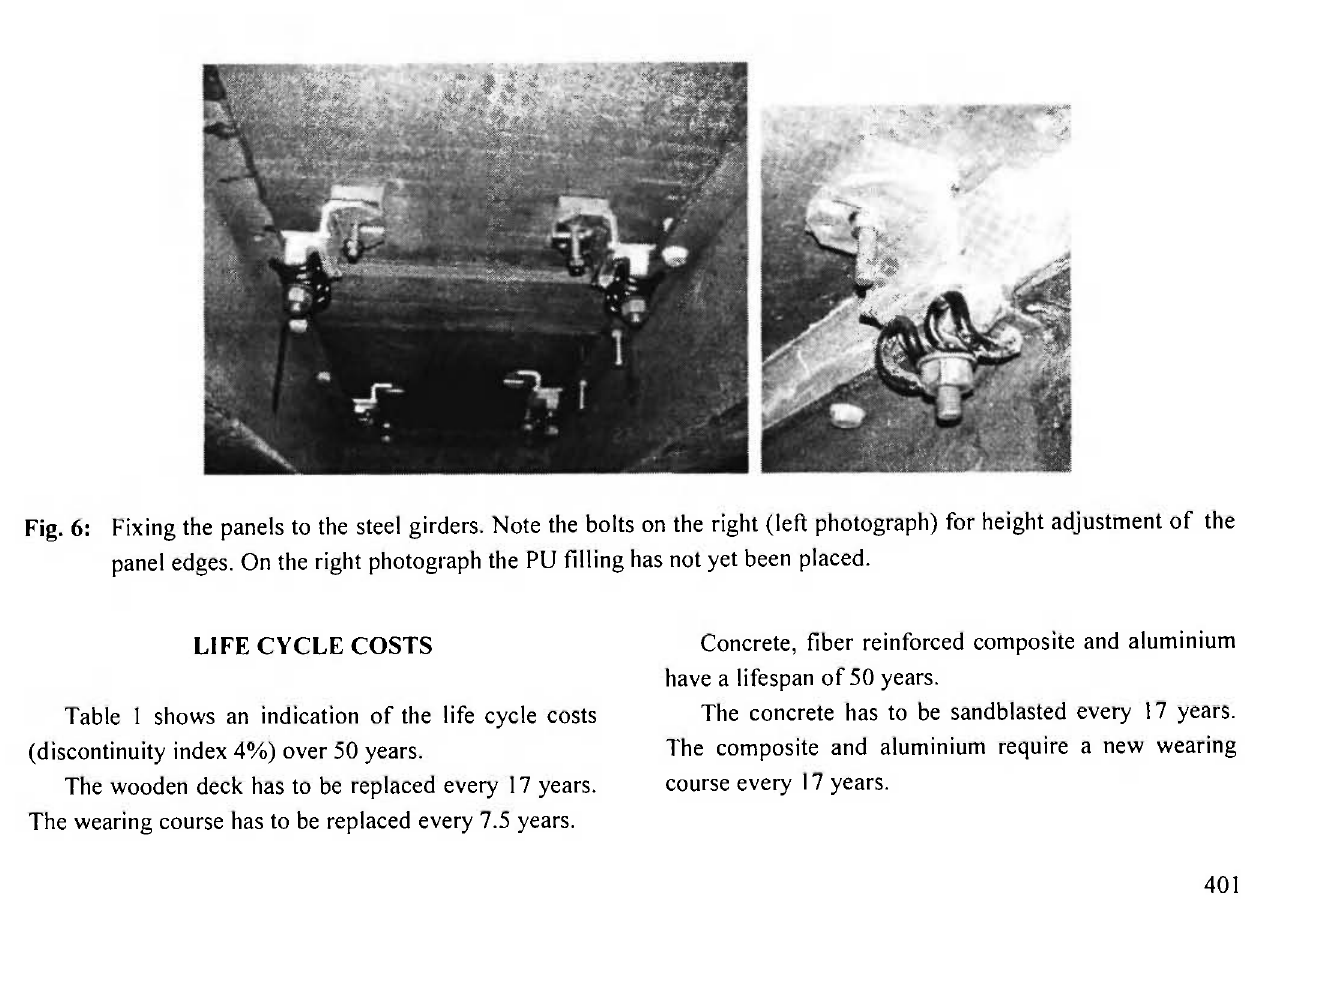
Fig. 5: Fatigue testing at TNO BOUW